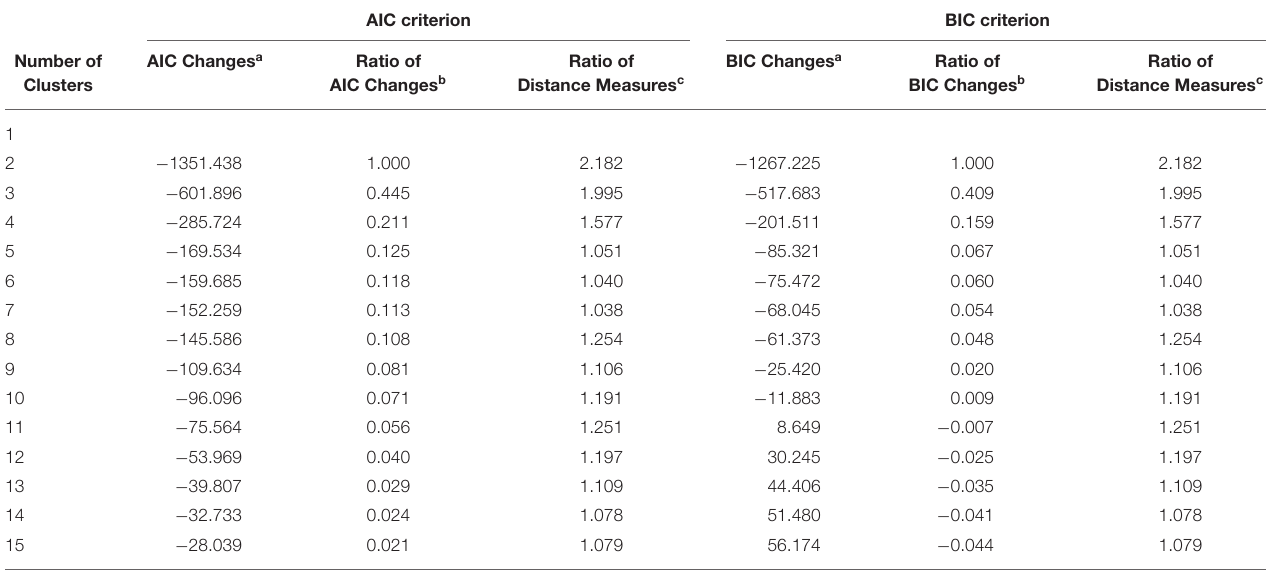
TABLE 1 | Sample-size adjusted and likelihood distances of the AIC and the BIC